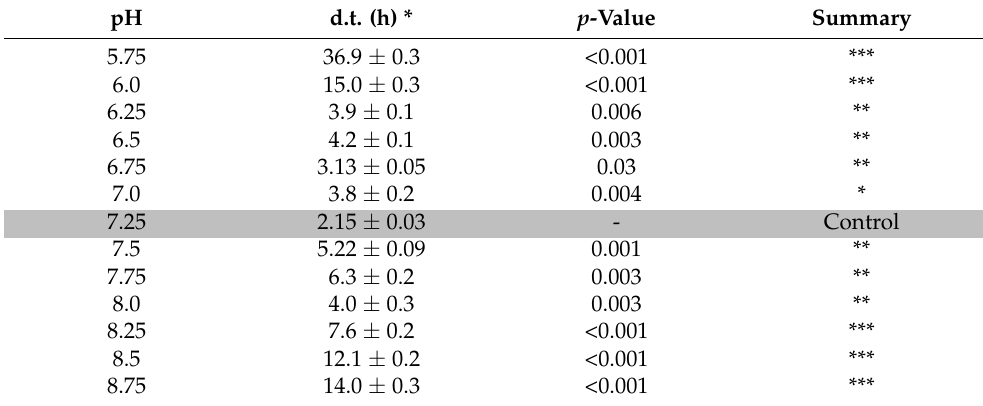
Table 2. Doubling time for Hfx. mediterranei growth under different pH stress conditions. pH p -Value